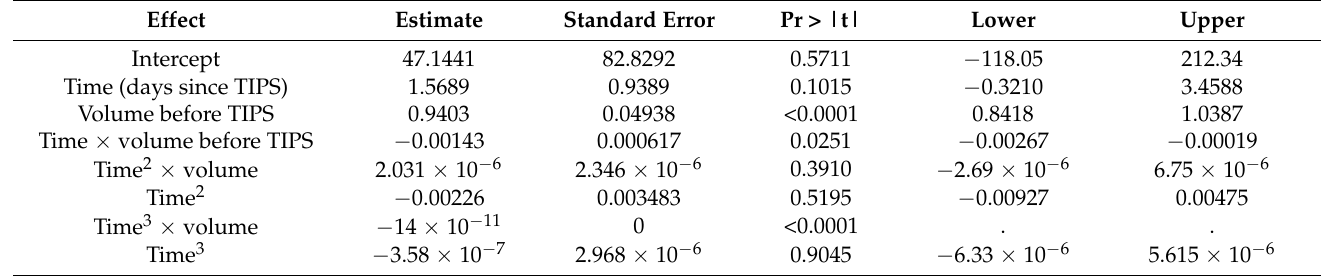
Table 5. Regression coefficients for the explorative model for total liver volume and time.